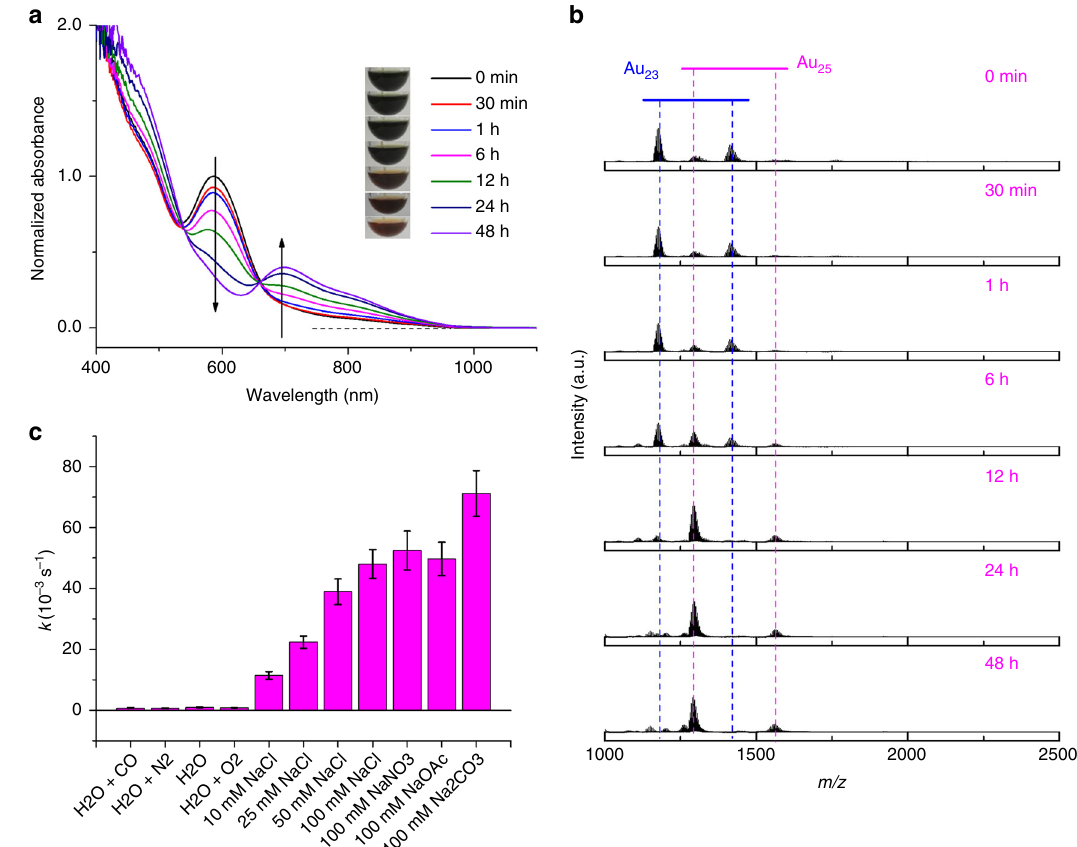
Fig. 2 Size-conversion kinetics from Au 23 to Au 25 nanoclusters. Time-course a ultraviolet-visible absorption and b electrospray ionization mass spectra of isoelectronic size conversion from [Au 23 (SR) 16 ] − to [Au 25 (SR) 18 ] − in water, where SR denotes thiolate ligand. c Rate constant ( k ) of the size-conversion reaction occurred in varied solutions, where OAc denotes acetate. The insets in a are digital photos of the reaction mixtures taken at varied reaction time. All absorption spectra are normalized to optical density at 589 nm at t = 0. The k values in c are deduced according to the characteristic absorption decay pro fi le of [Au 23 (SR) 16 ] − by a pseudo- fi rst-order reaction equation OD @589 = OD @589,0 × e − kt + b , where OD @589,0 and OD @589 are normalized initial and time-dependent optical density at 589 nm, respectively, whereas b is a constant accounting for the non-zero absorbance at 589 nm at the end state of reaction; the error bars indicate the SEs of the